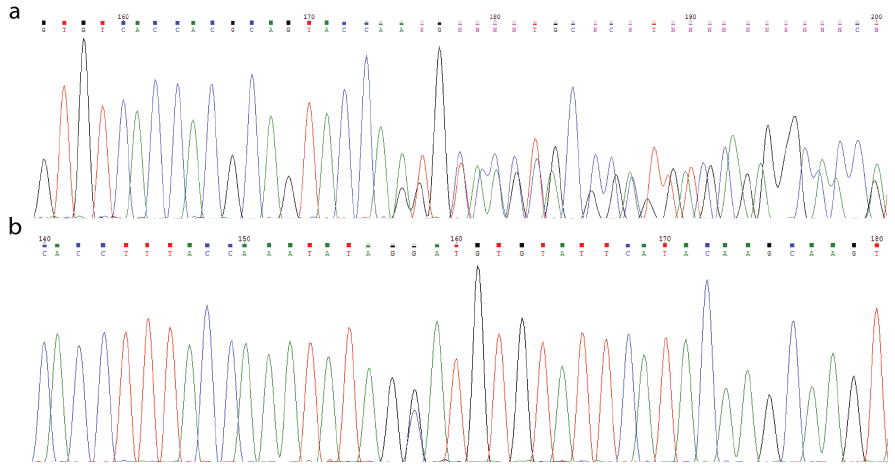
Figure 1. Electrophoretograms of the two novel LPIN1 variants. ( a ) NM_145693.2( LPIN1 ):c.[1949_1967dupGTGTCACCACGCAGTACCA] p.[Gly657Cysfs*12]. ( b ) NM_145693.2( LPIN1 ):c.[2410G>C]